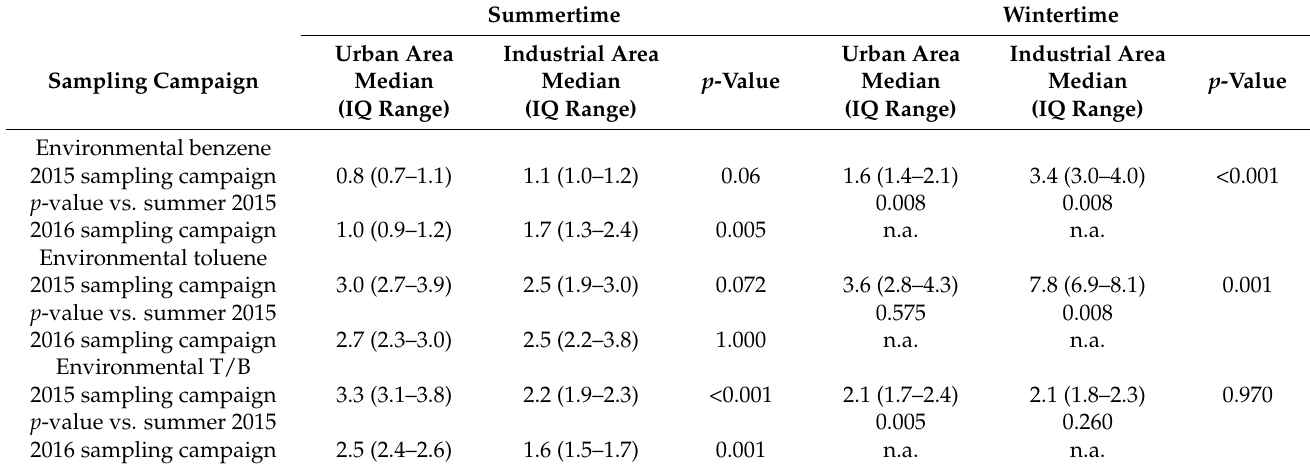
Table 3. Airborne benzene and toluene concentrations (expressed as µ g/m 3 ) in outdoor monitoring by study area.